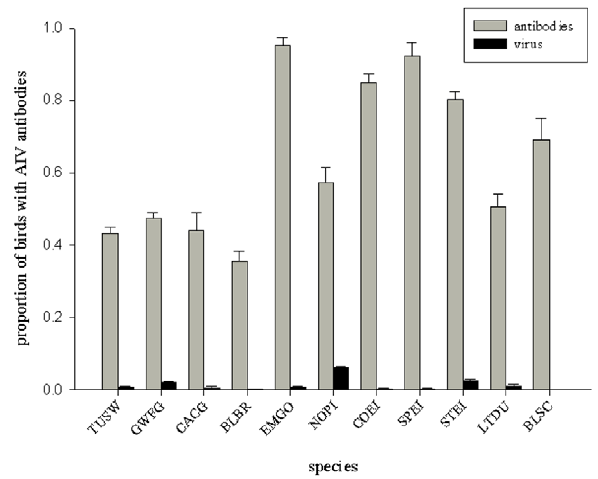
Figure 2. Overall prevalence rates ( ± s.e.) of avian influenza virus antibodies (gray bar) and avian influenza virus detection (black bar; based on pooled cloacal and oral-pharyngeal swabs; Ip et al. 2008, USGS/USFWS 2009, 2010) for adult waterfowl species in Alaska. Species abbreviations: TUSW = Tundra swan ( Cygnus columbianus ), CACG = cackling goose ( Branta hutchinsii ), BLBR = Pacific black brant ( B. bernicla nigricans ), GWFG = greater white-fronted goose ( Anser albifrons ), EMGO = emperor goose ( A. canagica ), NOPI = northern pintail ( Anas acuta ), COEI = Pacific common eider ( Somateria mollissima v-nigrum ), SPEI = spectacled eider ( S. fischeri ), STEI = Steller’s eider ( Polysticta stelleri ), LTDU = long-tailed duck ( Clangula hyemalis ), and BLSC = black scoter ( Melanitta nigra ).